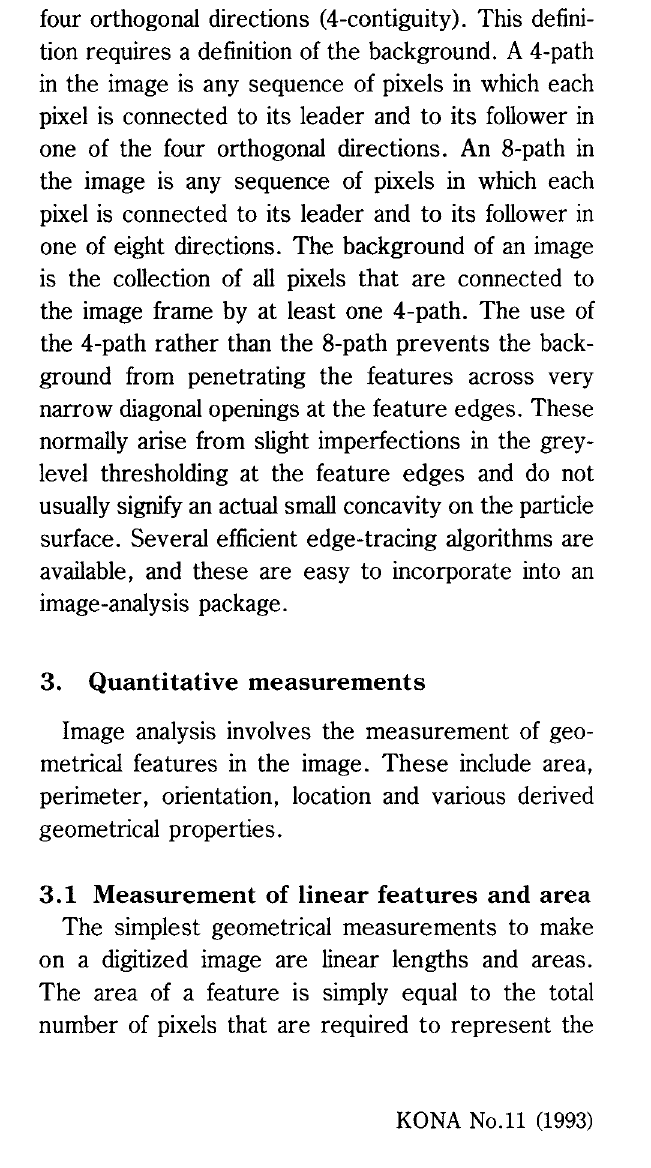
A "fingerprint" image of the bright phase in a 3-phase image. This is useful for the elimination of